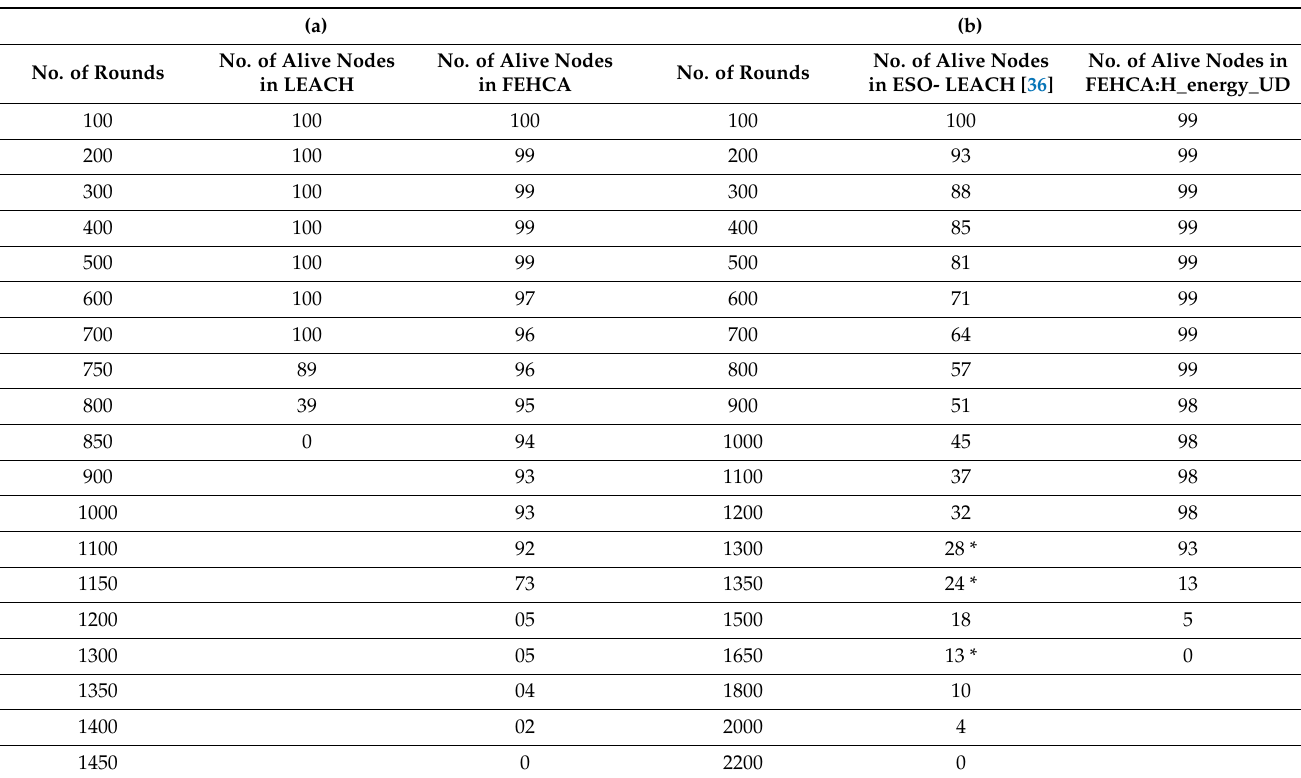
Figure 9. Performance of FEHCA and LEACH in terms of operational nodes per round when base station is positioned inside the deployment area. Table 2. ( a ) Network lifetime comparison of LEACH and FEHCA; ( b ) network lifetime comparison of ESO-LEACH and FEHCA:H_energy_UD.